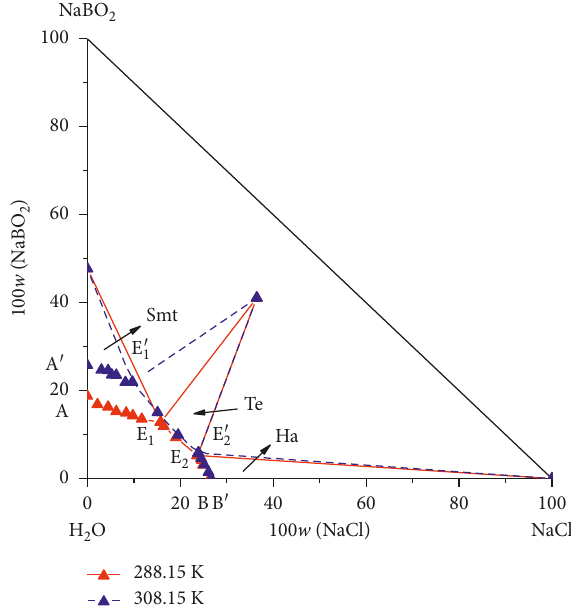
Figure 1: Comparison of the phase diagram of the ternary system (NaCl+NaBO 2 +H 2 O) between 288.15 and 308.15K at p 0 . 1 MPa. ( ) Experimental point; (—) solubility curve at (cid:30) 288.15 K; (- -) solubility curve at 308.15K; Smt, NaBO 2 2H 2 O; Ha, NaCl. NaCl NaBO 2 ▲ · ·